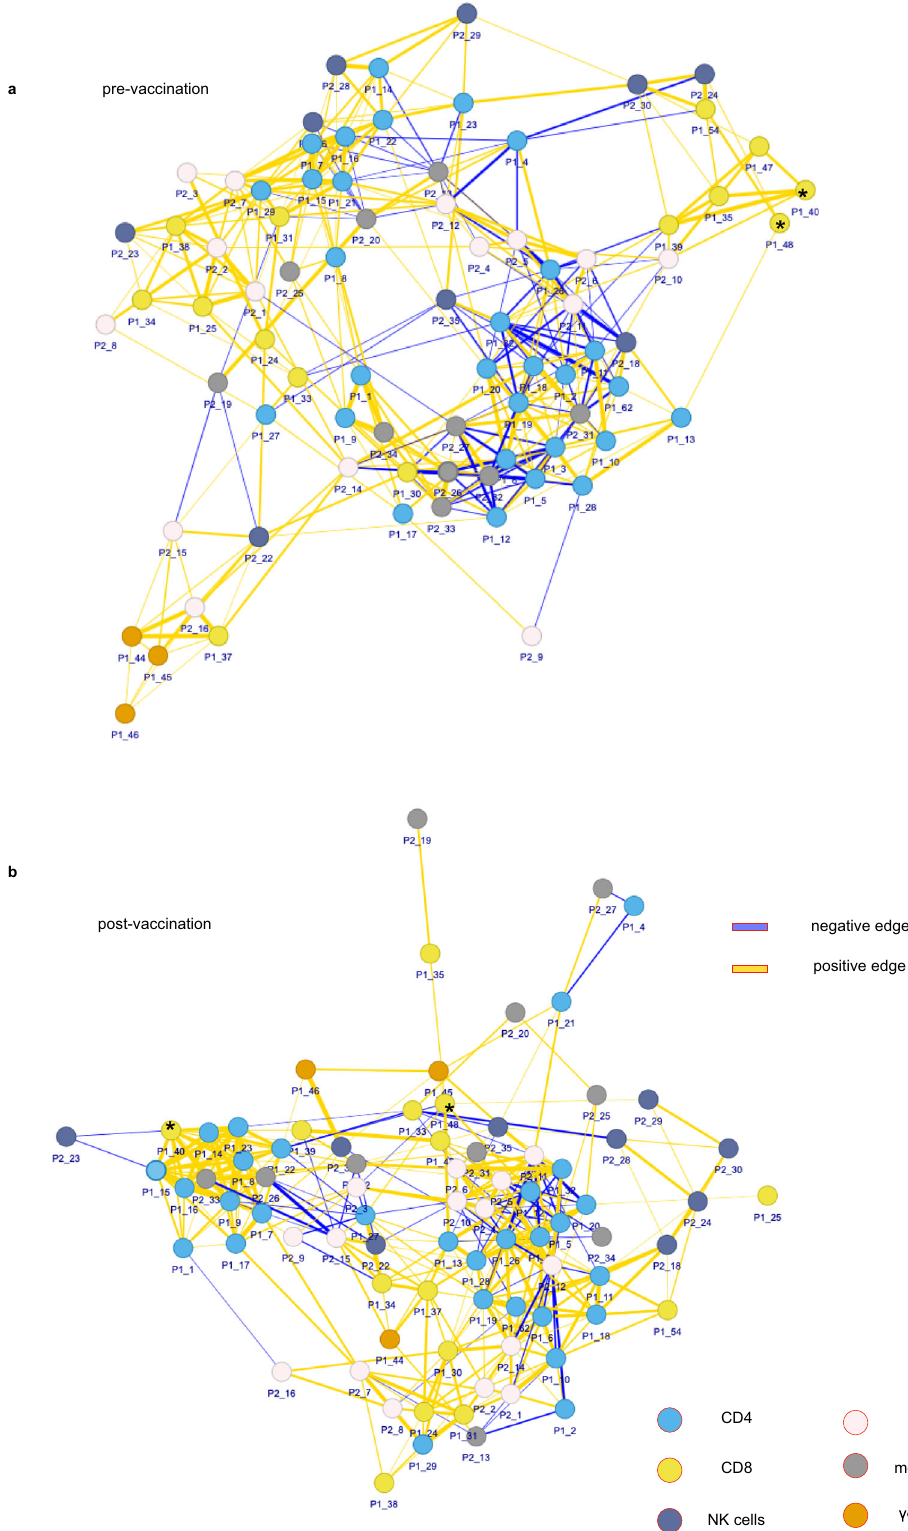
Fig. 3 | Vaccination reshapes immune networks in cancer patients. Network analysis of mass cytometry data in n =10 patients ( a ) pre and ( b ) post-vaccination (correlationcoef fi cient:0.6).Yellowedgesrepresentnegativecorrelationsandblue edges represent positive correlations. Nodes are coloured by cell type (blue: CD4,